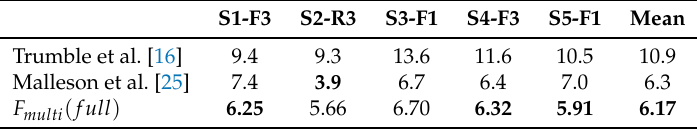
Table 2. 3D orientation error (degrees) on TotalCapture